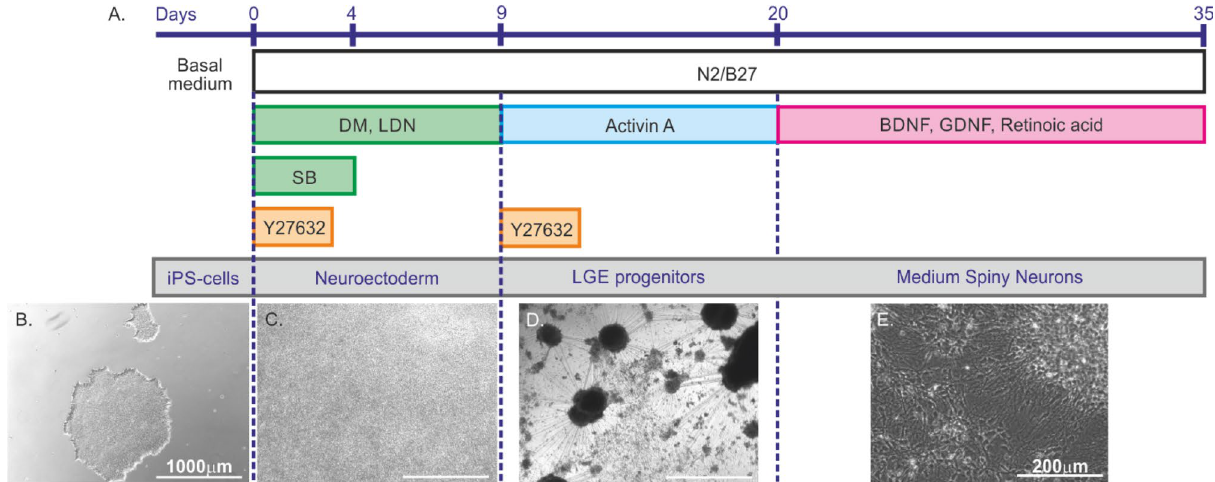
Figure 2. Schematic representation of the Fjodorova protocol. ( A ) Timeline of the differentiation protocol. DM, LDN and SB favor neural induction by inhibiting the dual SMAD signaling. Activin A induces a regional patterning towards the lateral ganglionic eminence that originates from the subpallium. The neuronal growth factors BDNF and GDNF terminate the differentiation into MSNs and mature the neurons. ( B ) hiPS cells grow in basal medium until DIV0. ( C ) Between DIV0 and DIV9, hiPS cells grow into neuroectodermal cells. ( D ) From DIV9 to DIV20, Activin A application induces the formation of lateral ganglionic eminence (LGE) progenitors. ( E ) Between DIV20 and DIV35 ± 3, the LGE progenitors mature under the influence of neuronal growth factors. Scale bar: 1000 µm ( B , C , D ) and 200 µm ( E ). The dotted lines delineate the different developmental stages during differentiation of MSNs from hiPS